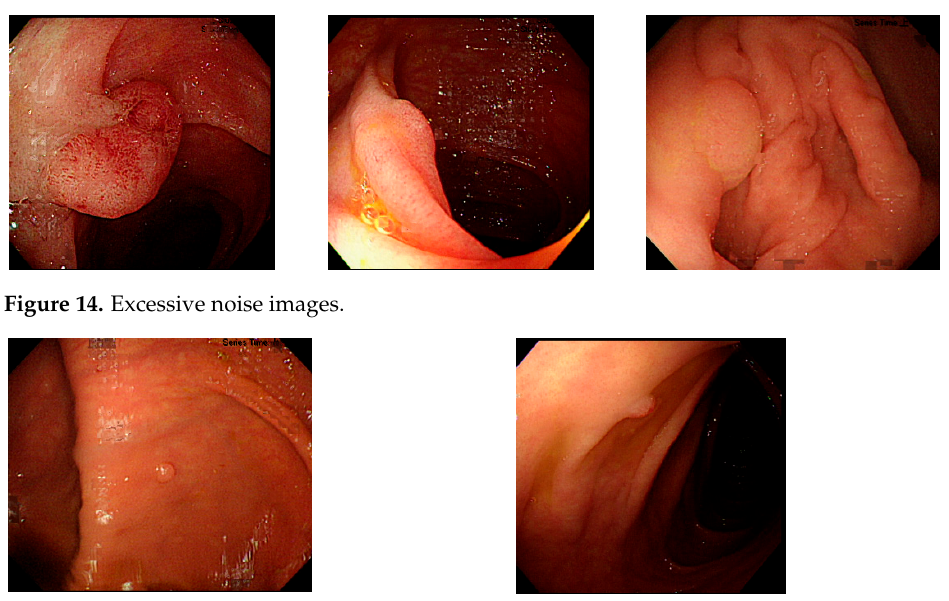
Figure 13. Nonobvious polyp protrusions or similar to intestinal wall.